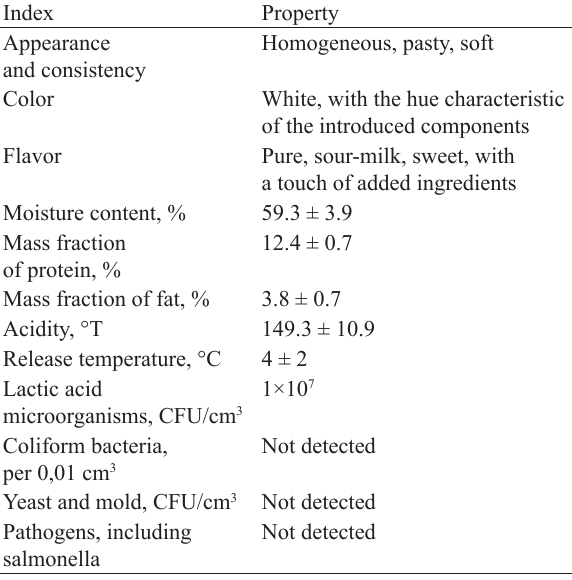
Table 6 Sensory, physico-chemical, and microbiological indicators of the cottage cheese fortified with biologically active substances extracted from Scutellaria galericulata